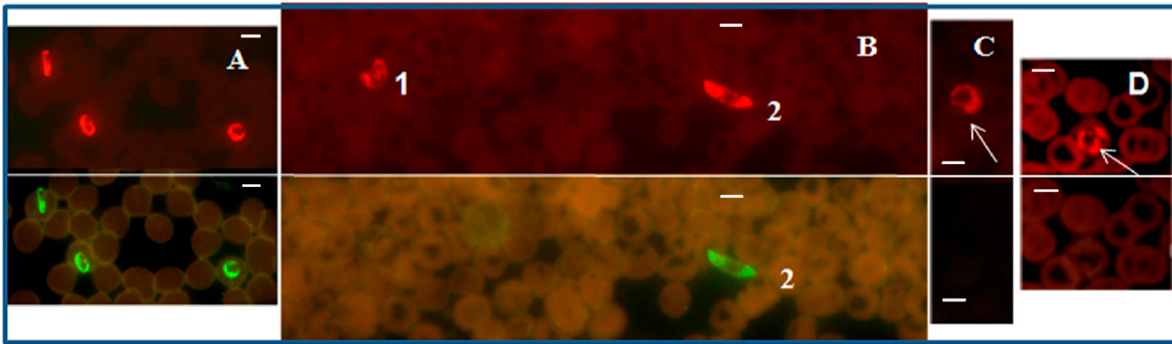
Figure 2. P. falciparum -specific PF-FISH test. Photographs showing results from the PF-FISH test performed on thin blood smears in patients from Peru and Kenya infected with: ( A ) P. falciparum ; ( B ) 1. P. malariae and 2. P. falciparum ; ( C ) P. ovale ; ( D ) P. vivax . The P. falciparum -specific probe and Plasmodium genus-specific probe fluoresce green and red, respectively, in the same field when viewed with appropriate light filters. The scale bars represent approximately 5 µm. Figure repro-